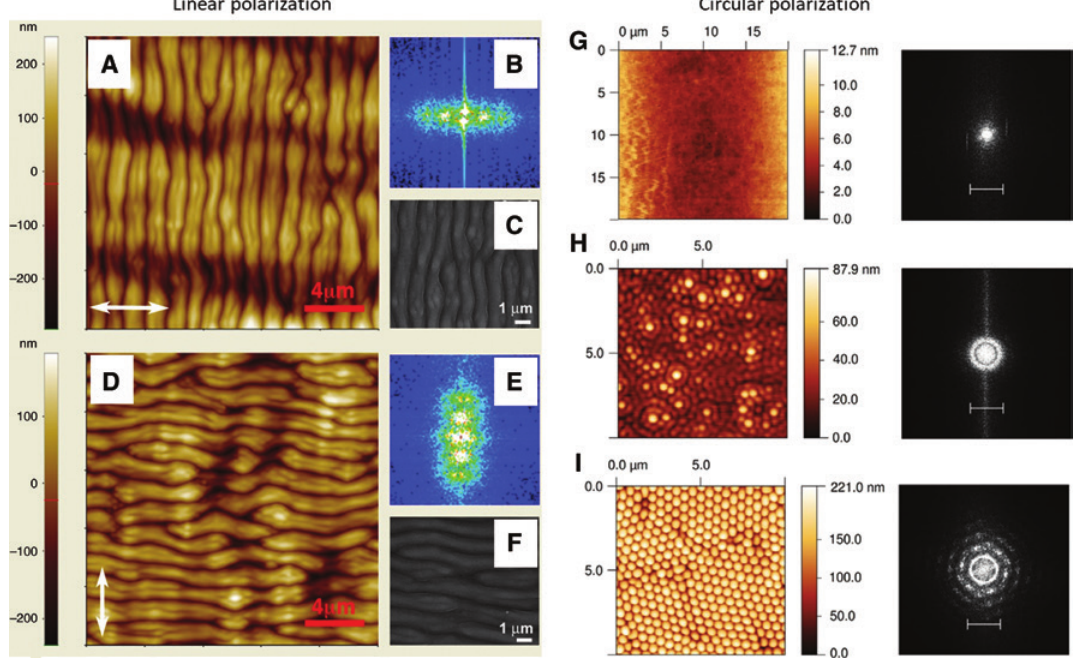
Figure 5: SSRGs generated by linearly and circularly polarized single beams. AFM images (A and D), 2D Fourier transform (B and E) and SEM images (C and F) of the SSRGs induced by a collimated beam, linearly polar- ized along the two orthogonal directions indicated by the white arrows. (A–F) reproduced from Ref. [138] with permission from AIP Publish- ing. (G–I) AFM images and their relative Fourier transforms of the SSRGs at different exposure times obtained with a circularly polarized beam. Adapted from Ref. [143] with permission from